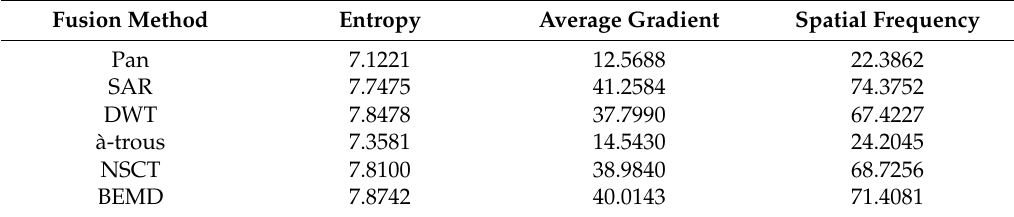
Table 1. Evaluation of different fusion methods in Figure